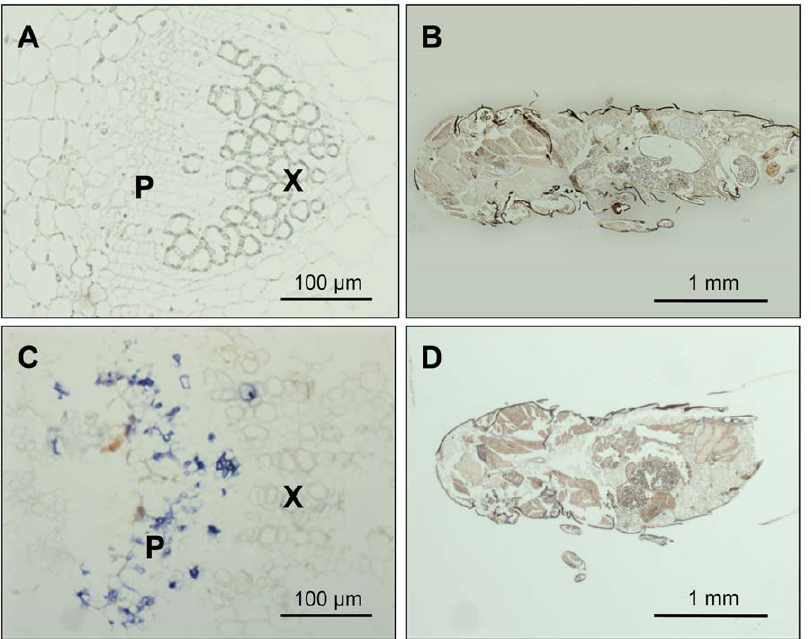
Figure 8. Localization of the phytoplasmal secreted protein, PAM486, detected by immunohistochemical analyses with anti- PAM486 antibody. X and P indicate xylem and phloem, respectively. (A) Immunohistochemical analyses of healthy garland chrysanthemum tissue section. (B) Immunohistochemical analyses of healthy leafhopper ( Macrosteles striifrons ) tissue section. (C) Immunohistochemical analyses of phytoplasma-infected garland chrysanthemum tissue section. (D) Immunohistochemical analyses of phytoplasma-infected leafhopper tissue section. Blue signals indicate the presence of the secreted protein PAM486. A phytoplasma-infected plant and a phytoplasma-infected insect were sectioned at 8 m m